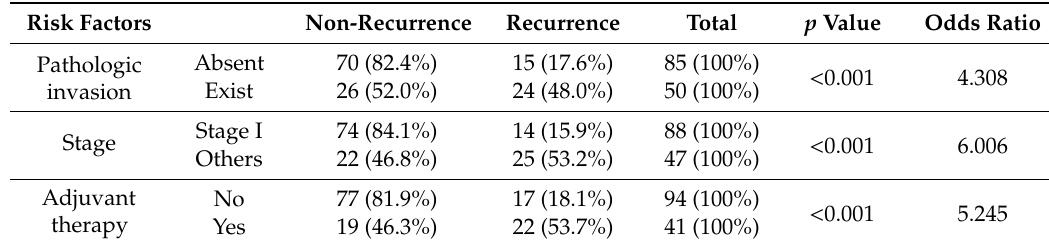
Table 2. Risk factors for